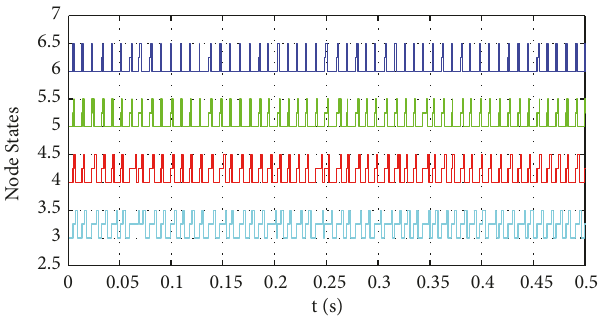
Figure 8: Network scheduling results ( T =0.015s, P =3).